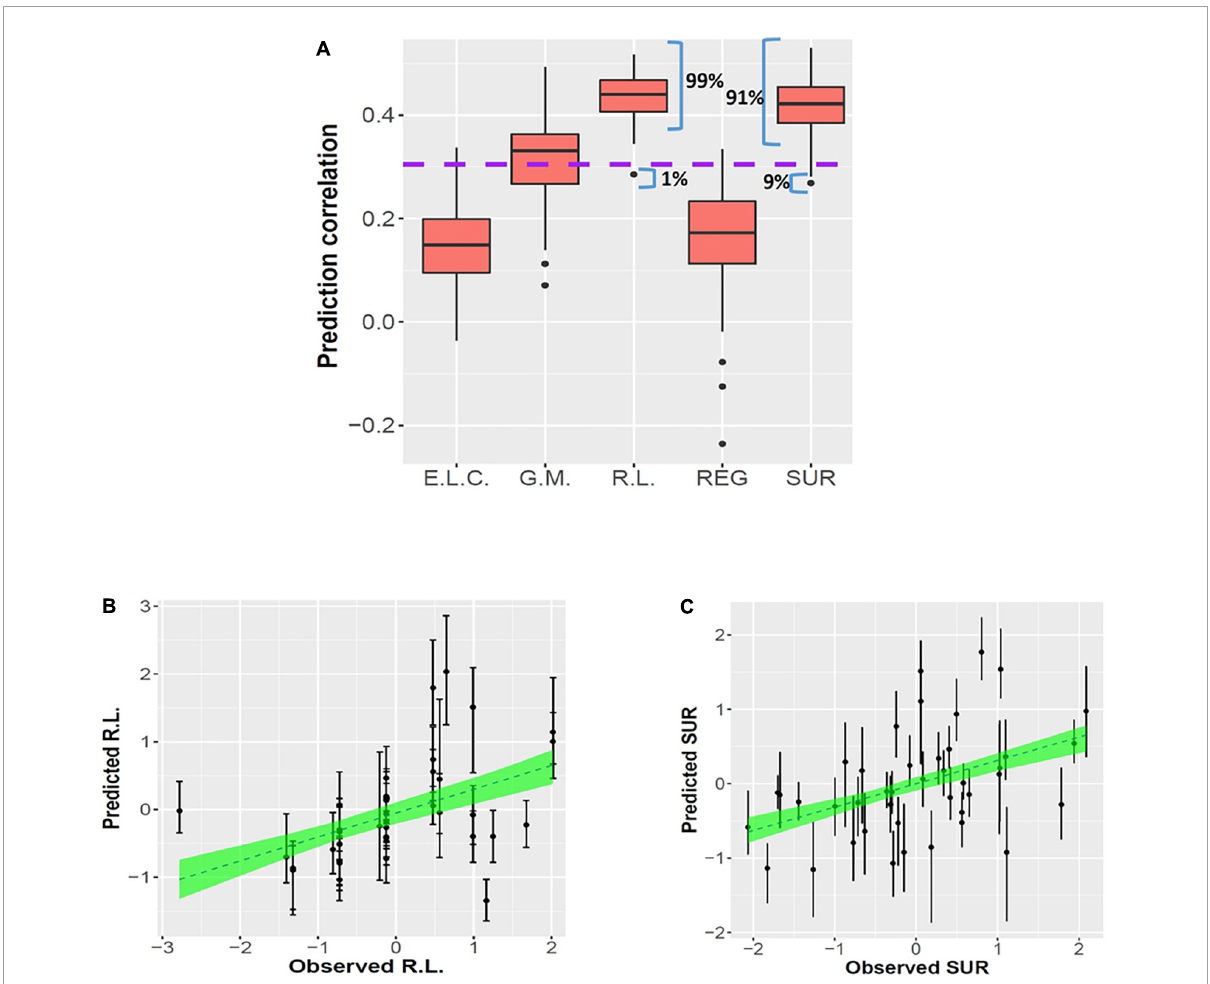
FIGURE6 Prediction results for linear regression models from 100 random splits of 5-fold CV. Panel (A) shows the boxplots of 100 Pearson’s correlations between the observed and predicted MSEL scores, including the early learning composite score (E.L.C.), gross motor (G.M.), and receptive language score (R.L.) and IBQ-R factors including the regulation (REG) and surgency (SUR), respectively, based on 100 repetitions of CVs. The purple dashed line represents the significance threshold of the correlation at α = 0.05 with n = 38 subjects. Panels (B,C) show the observed R.L. (left) and SUR (right) vs. the predicted R.L. and SUR of the 100 times’ predictions, respectively. The dashed lines and the green areas show the mean and the 95% confidence intervals of the fitted linear slopes between the observed and predicted observations,